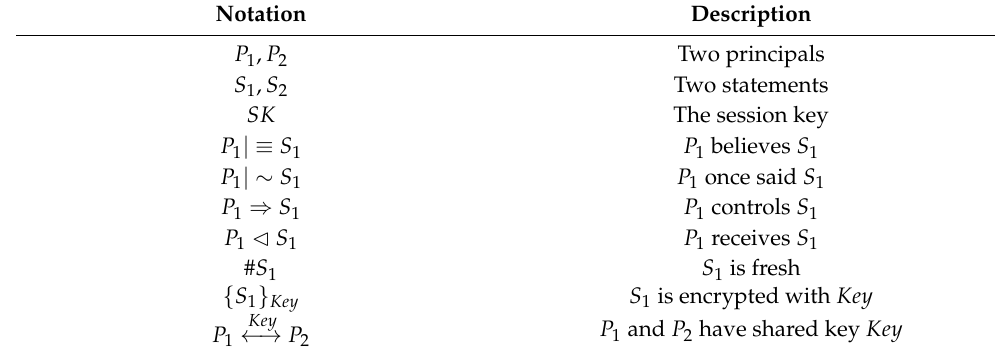
Table 2. The basic